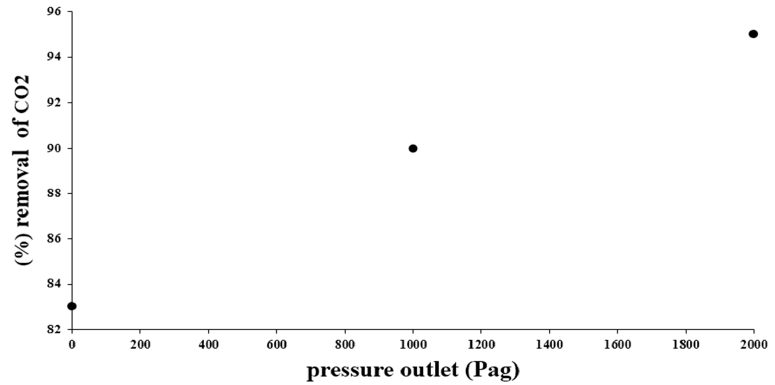
(cid:3036),(cid:3004)(cid:3016) (cid:3118) and 𝑌 (cid:3033),(cid:3004)(cid:3016) (cid:3118) are the initial and final mass fraction of CO 2 in the gas phase